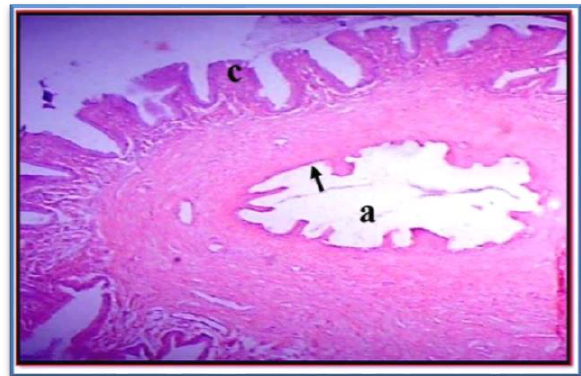
Figure,6 : Histological section of papillae showing a- lumen of papillae duct, , c- stratified squamous epithelium of urodeum. (arrow) - Non ciliated pseudostratified columnar epithelium H&E stain